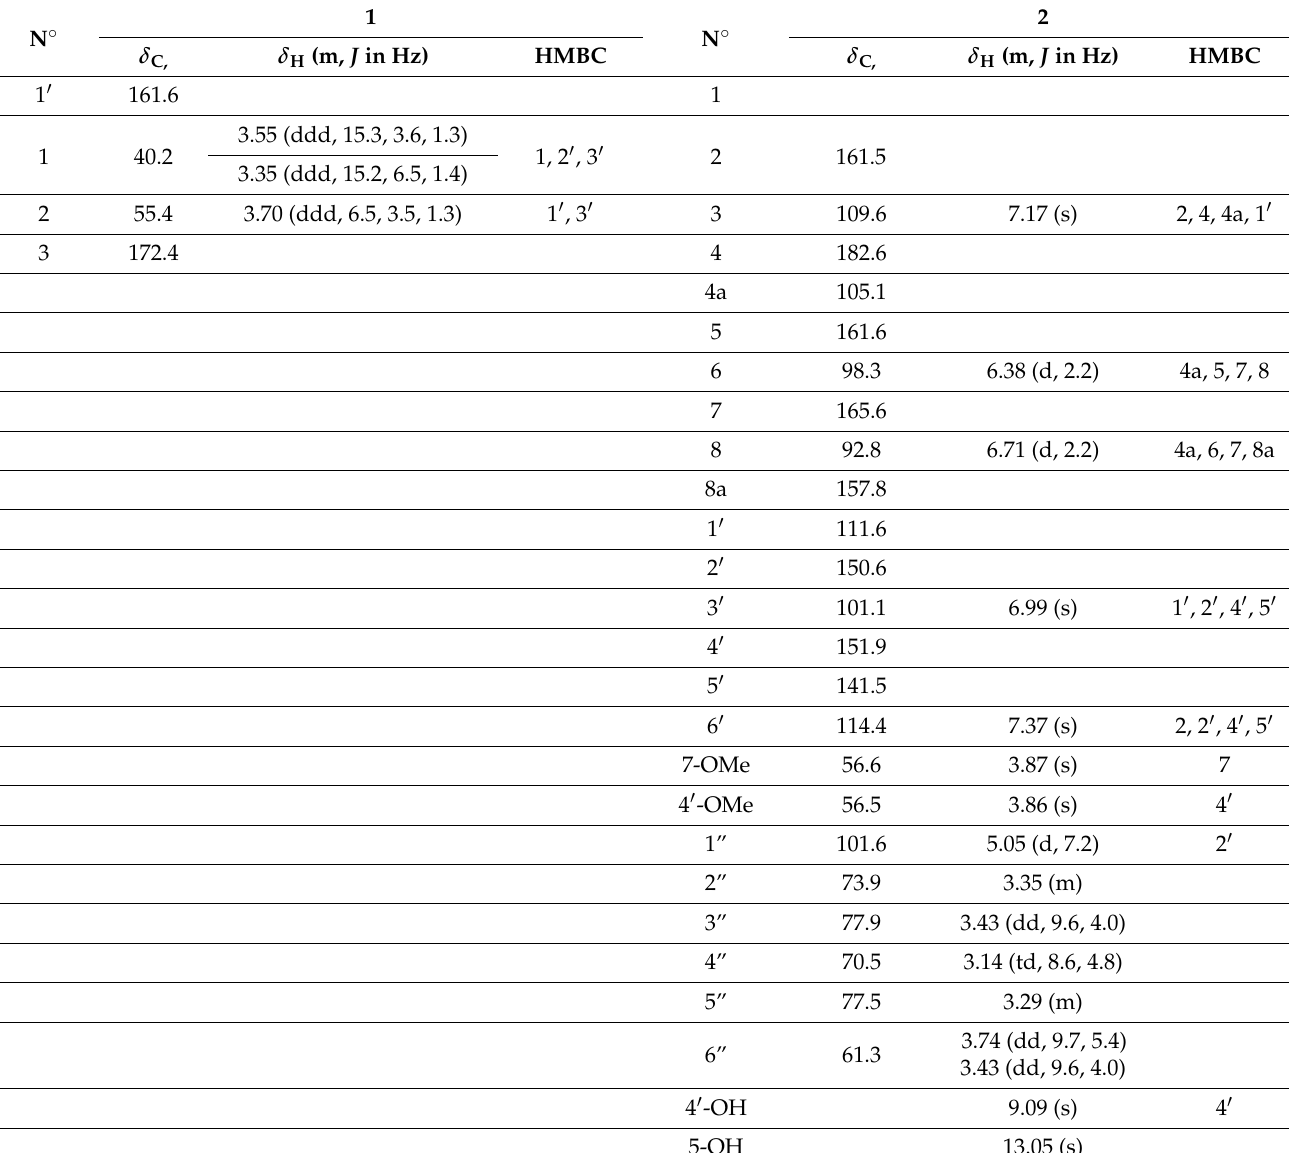
Table 1. 13 C and 1 H-NMR spectroscopic data ( 1 H 600 MH Z , 13 C 150 MH Z for compounds 1 (in D 2 O) and 2 (in DMSO- d 6